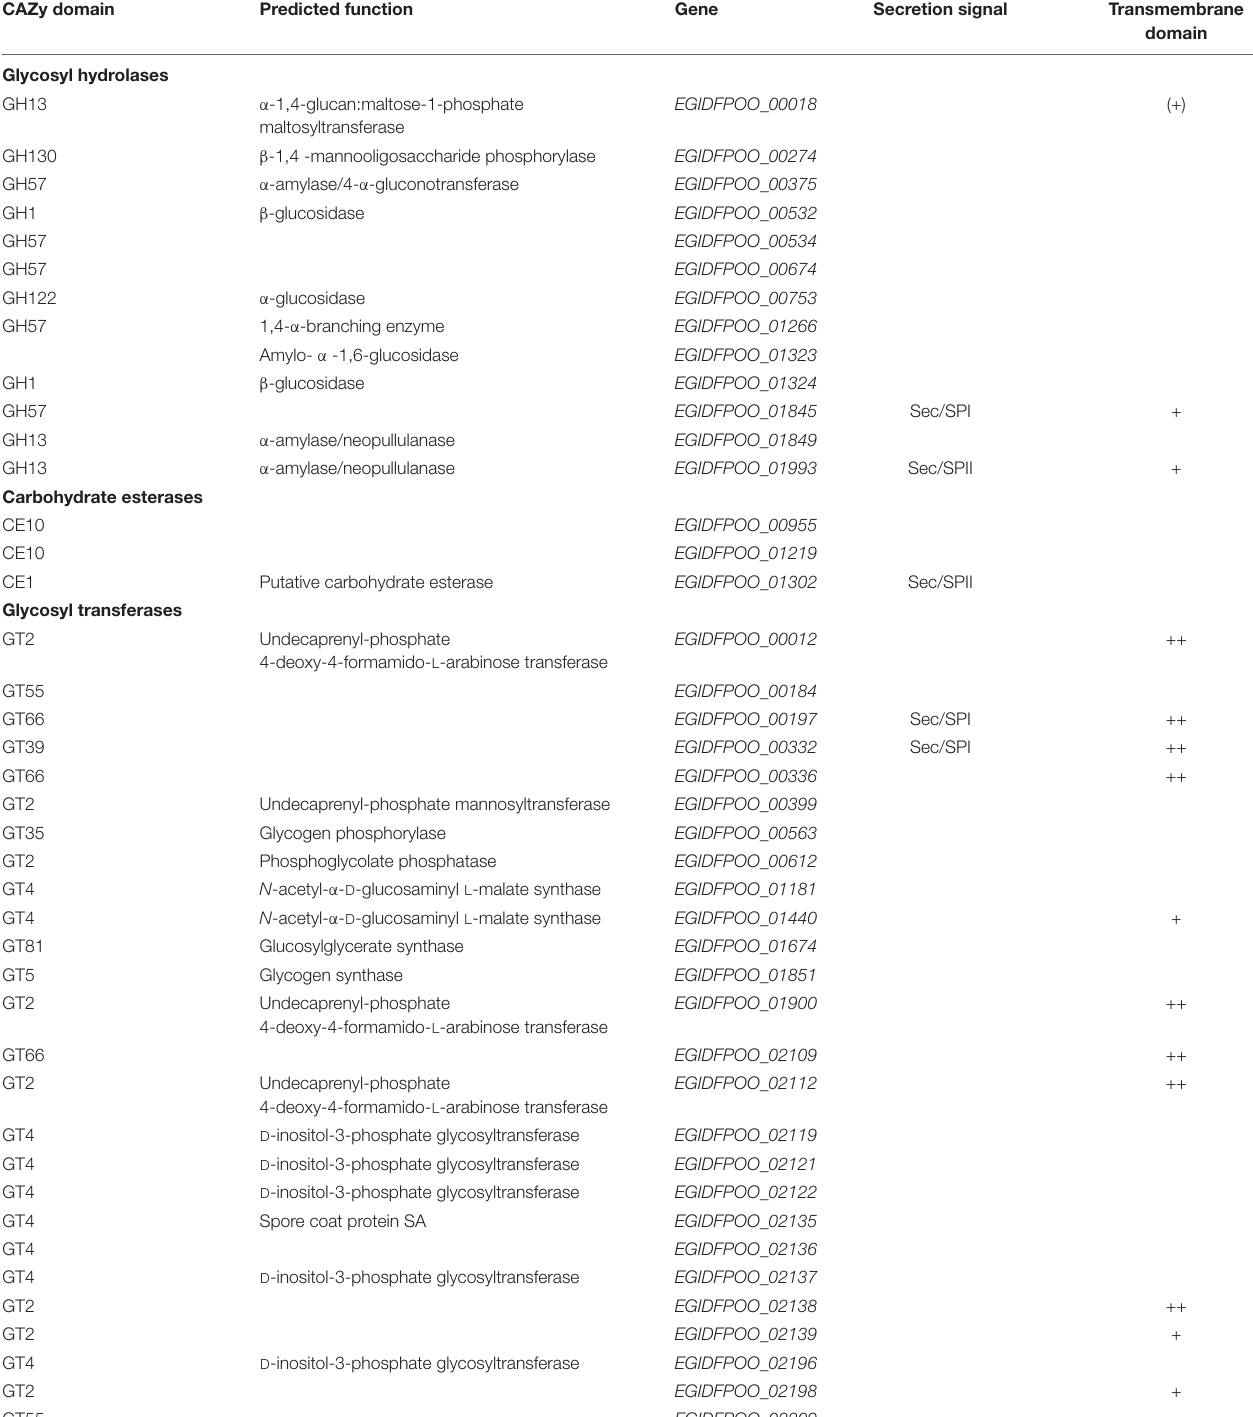
TABLE 1 | CAZymes identified in the Thermococcus sp. strain 2319x1E genome. CAZy